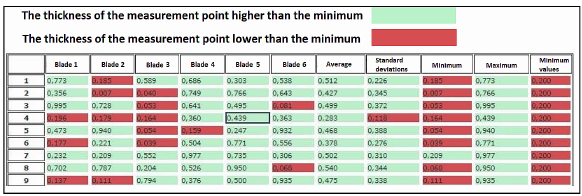
Figure 7: Example of a measurement